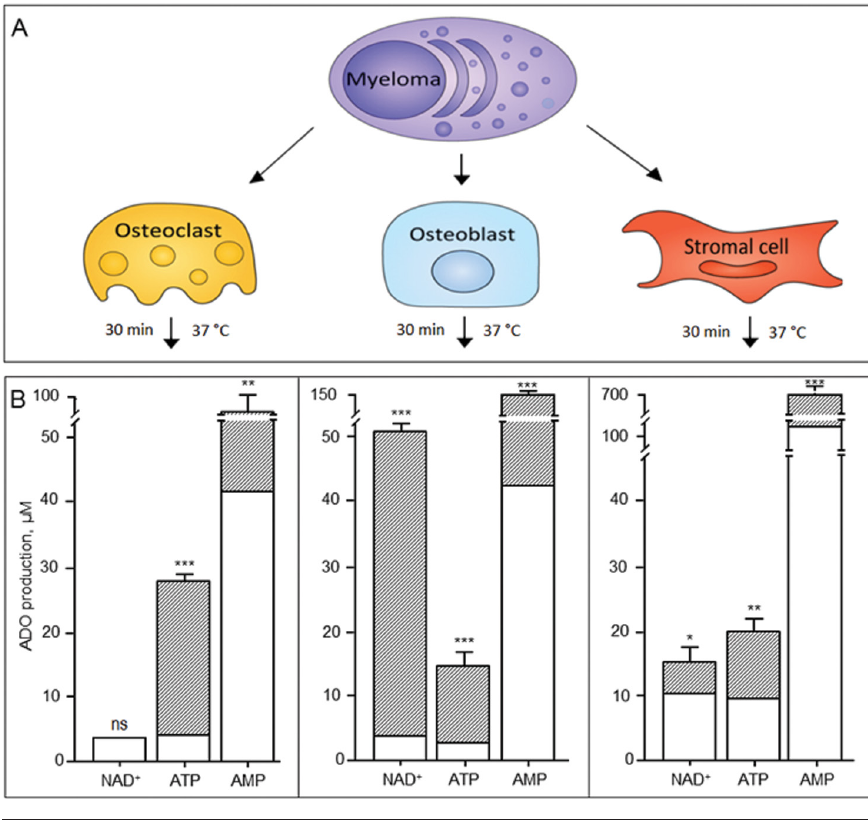
Figure 5. ADO production by mono- and co-cultures of myeloma cells with different components (osteoblasts, osteoclasts and stromal cells) of the BM niche. (A) Scheme of the co-culture system involving direct cell-cell contacts. (B) ADO generation ( µ mol/L) assayed in supernatants of mono- ( ) and co-cultures ( ) after adding NAD + (CD38/ CD203a/CD73-dependent), ATP (CD203a/CD73-dependent) or AMP (CD73-dependent) for 30 min at 37°C. Supernatants were collected and analyzed by HPLC. Variability (fold-increase) of ADO levels were detected after exposing osteoclasts (differentiated PBMC), osteoblasts (SAOS-2 cell line) and stromal cells (HS-5 cell line) to the LP-1 myeloma cells after adding NAD + , ATP or AMP. Values are the mean ± SD of triplicate determinations. All data are representative of at least three